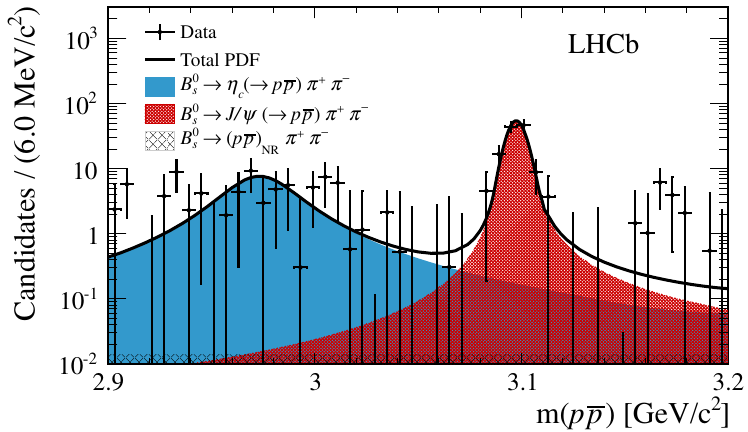
Figure 2 . Distribution of p (cid:22) p invariant-mass for B 0 ! p (cid:22) p(cid:25) + (cid:25) (cid:0) candidates obtained by the s P lot s technique. The solid black curve is the projection of the total (cid:12)t result. The full blue, tight- cross-hatched red and wide-cross-hatched black histograms show the (cid:17) c , J= and nonresonant p (cid:22) p contributions, respectively. The structure visible around 3 : 15 GeV is found to be consistant with a statistical (cid:13)uctuation.